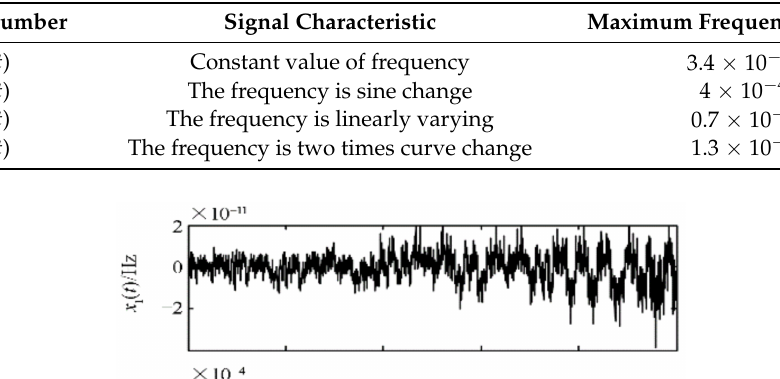
Table 1. Tracking precision of frequency measurement algorithm.